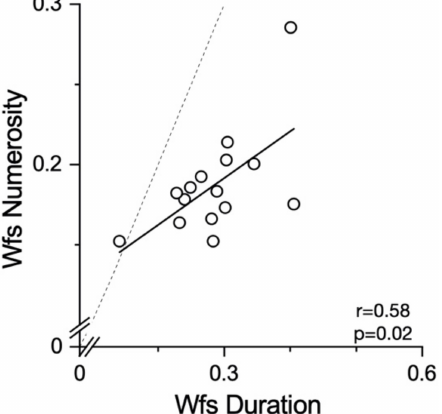
Figure 8. Correlation between numerosity and duration Wfs. Scatter plot of individual Wfs as averaged across conditions for duration and